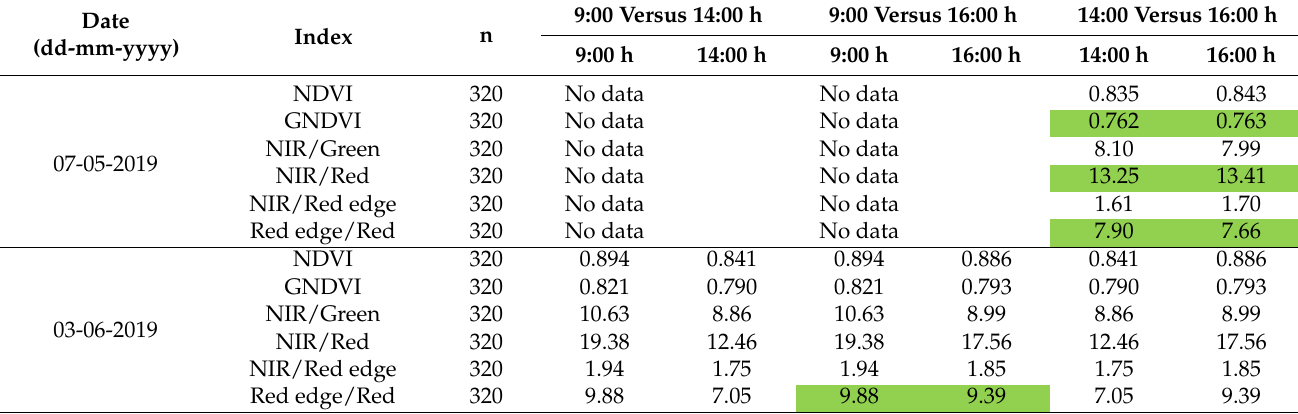
Table 5. Mean values of each vegetation index for paired measurement times (9:00 versus 14:00 h, 9:00 versus 16:00 h, and 14:00 versus 16:00 h) were measured with a UAV on each measurement date. Green shading indicates non-significant differences between paired measurement times using t -Tests; all other pairs were statistically different ( p < 0.016, after Bonferroni correction for multiple